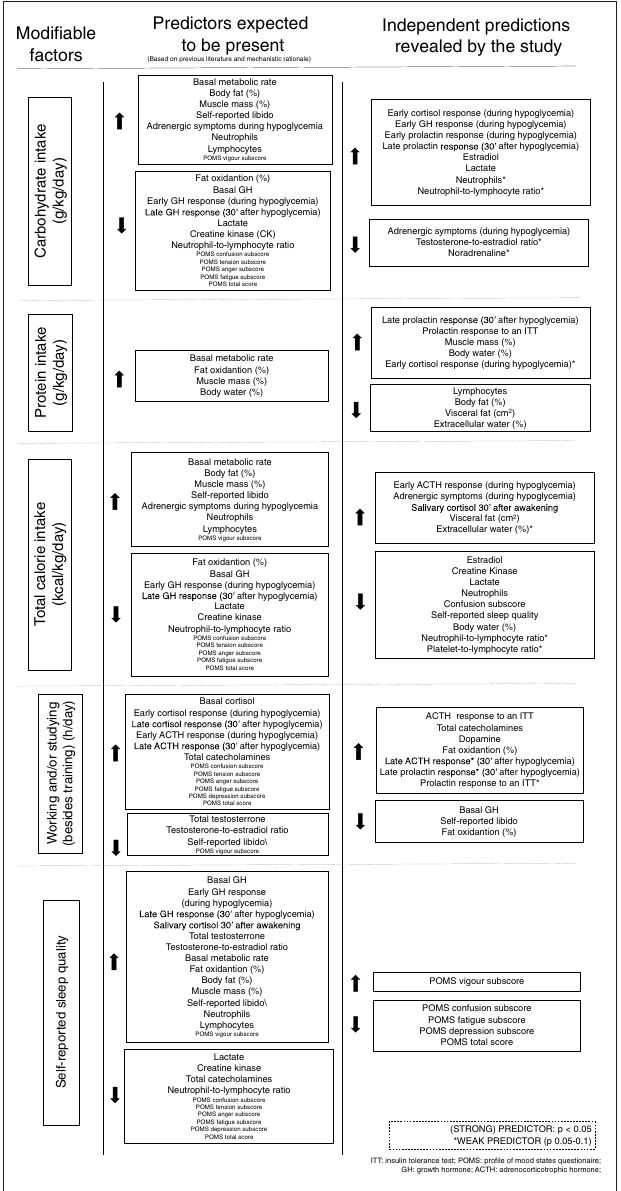
FIGURE 2 | Expected and actual predictions of each modifiable